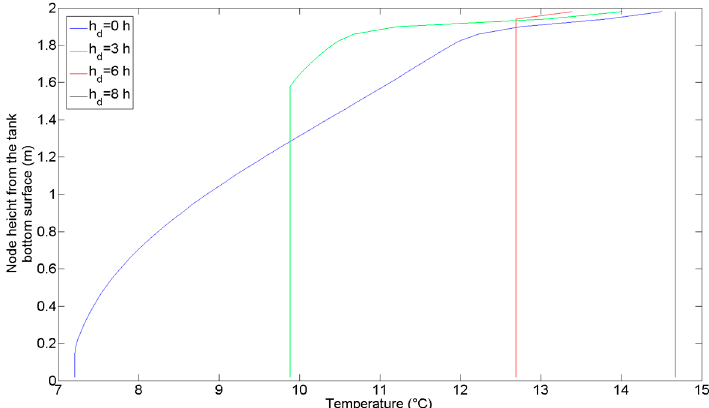
Figure 14. Temperature profiles in the cold water tank during the discharging phase (h d = 0 h refers to the beginning of the phase).